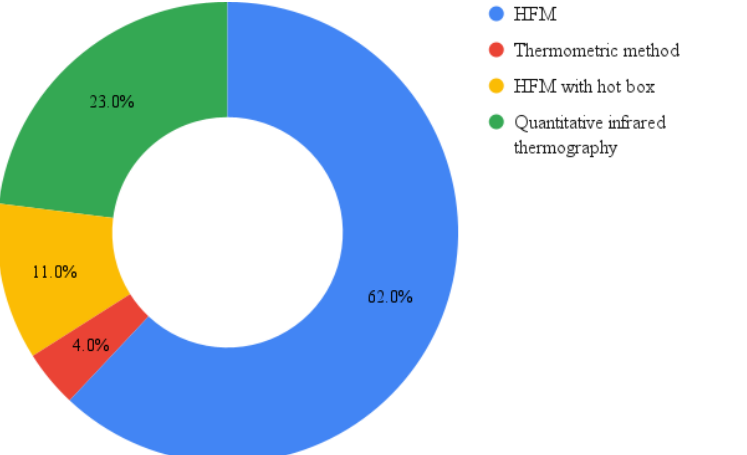
Figure 1. Distribution of research articles for each defined in-situ method for U -value determination according to